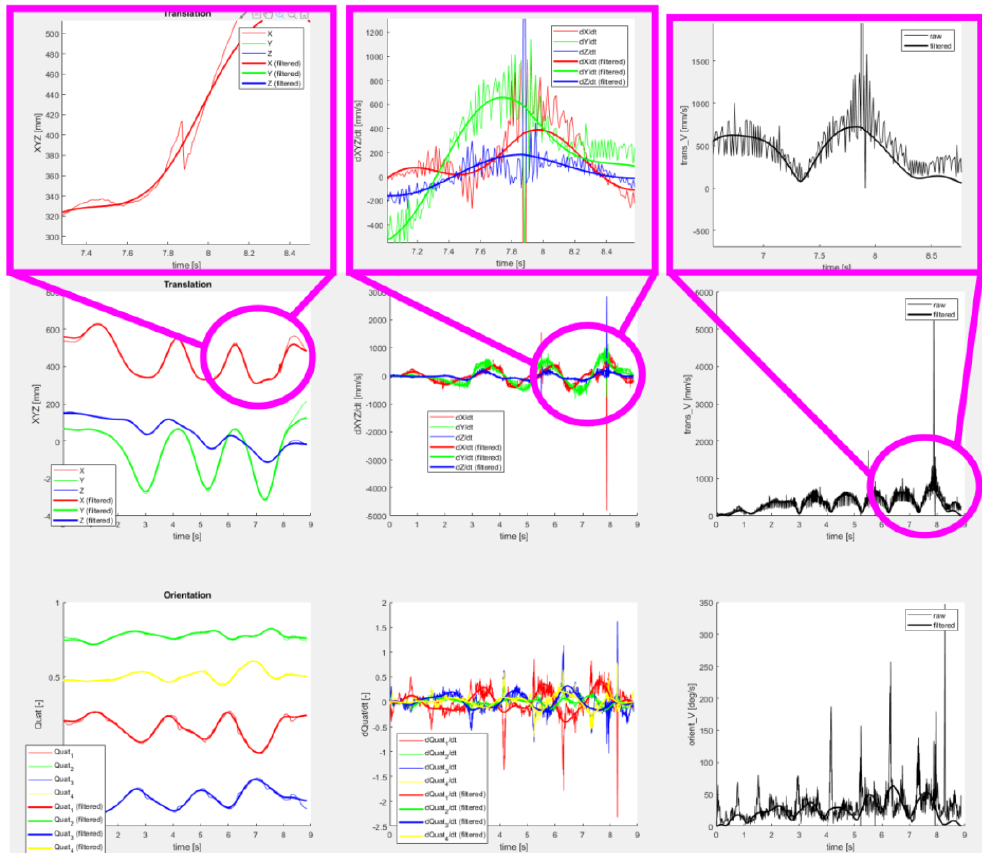
Figure 15. Pilot application—example of spraying motion task recorded by operator and post- processed by the software, ( top ) details of specific parts of the trajectory showing the smoothing functionality of the post-processor, ( center ) translation data in the individual axes showing position, velocities and feedrate, ( bottom ) orientation data showing quaternion elements, their derivatives and rotational